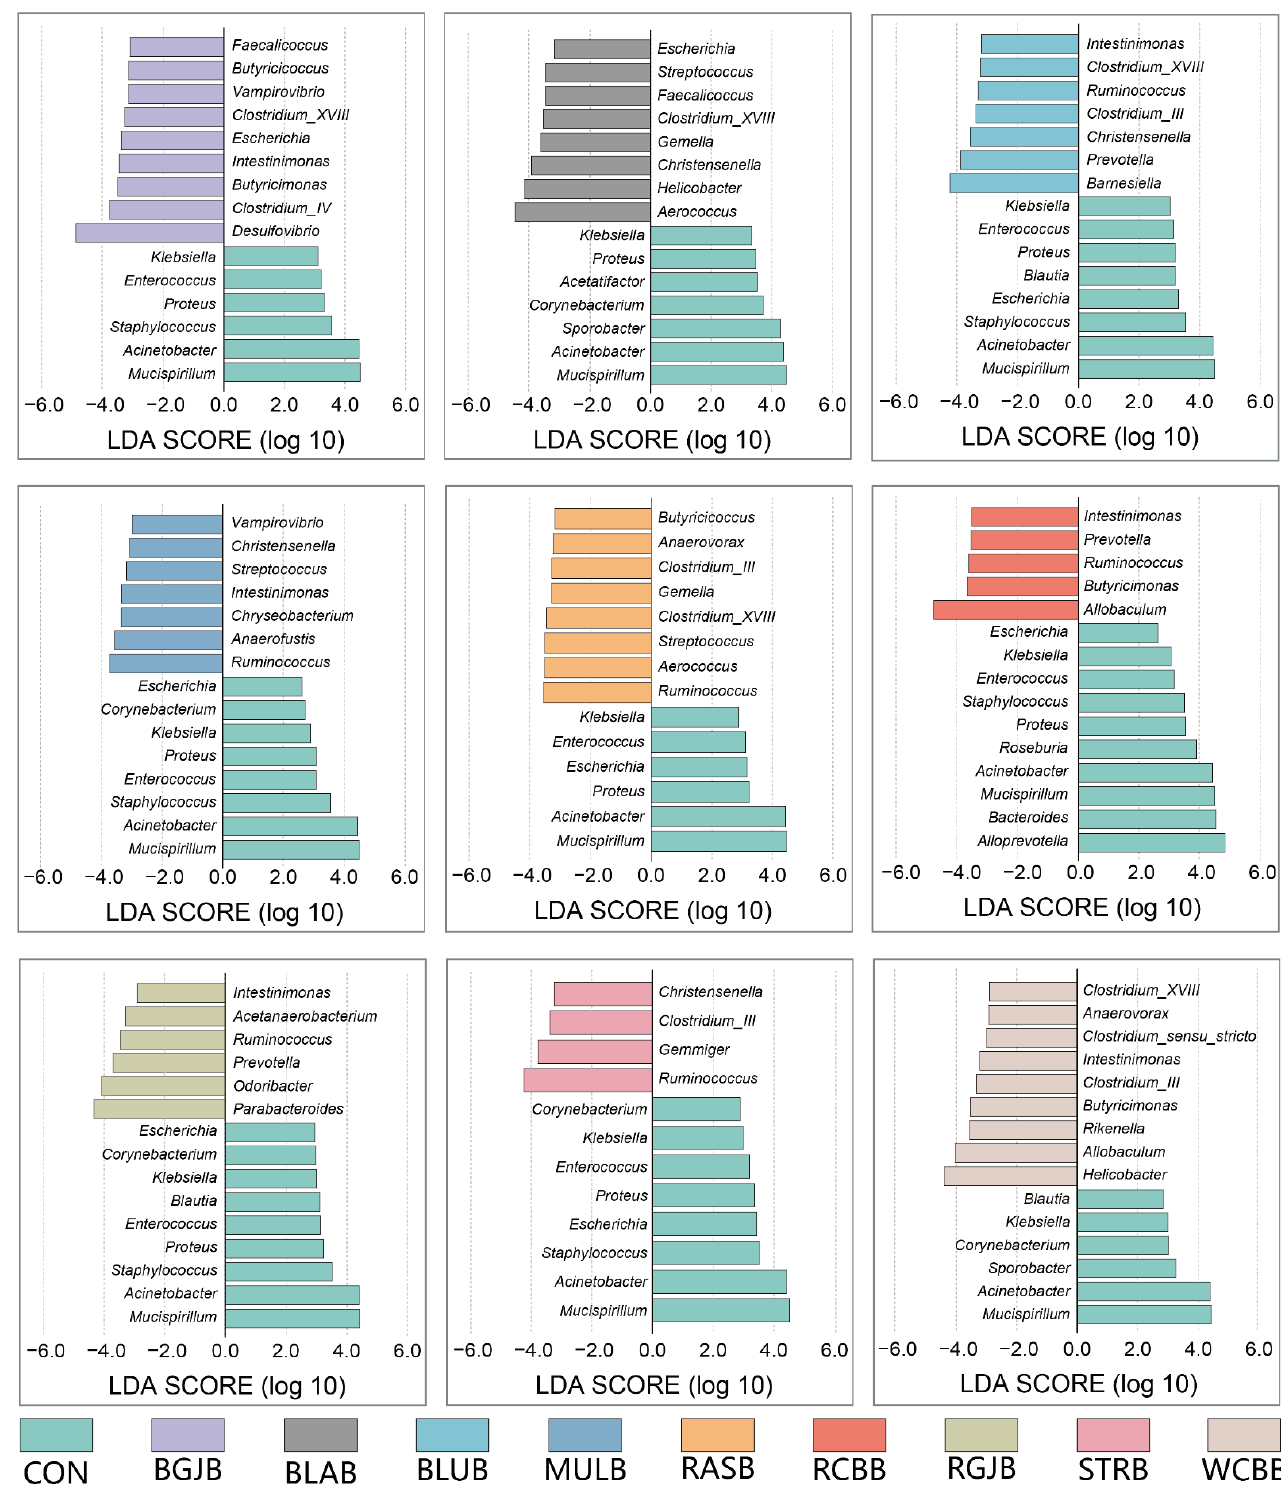
Figure 5. LEfSe analysis for differential abundant taxa detected between control group and each berry group. Threshold parameters were set as p = 0.05 for the Mann-Whitney U test. Linear discriminant analysis (LDA) score was >2.0.